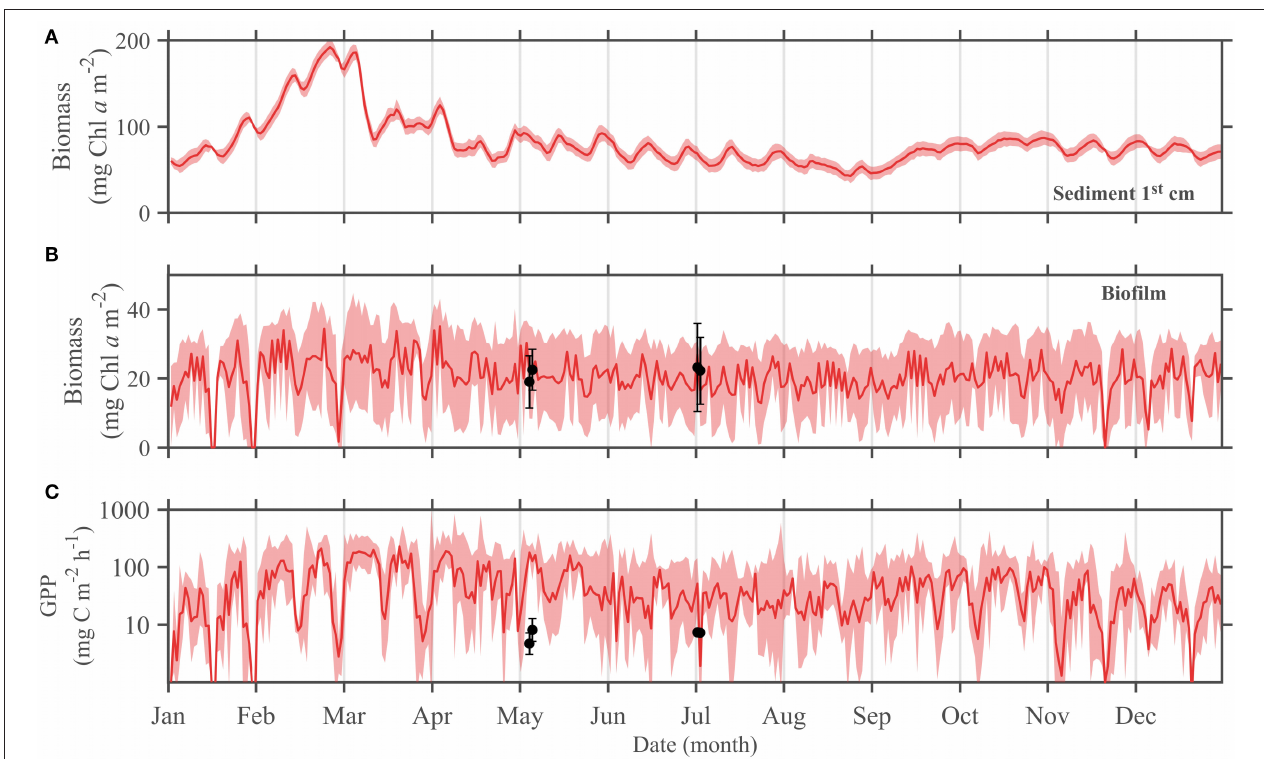
FIGURE 4 | Simulated mean seasonal cycle (MARS-3D season run) of the 2015 (A) daily mean MPB biomass in the sediment 1st cm, (B) daily mean MPB biomass in the biofilm (mg Chl a m − 2 ) and (C) hourly GPP (mg C m − 2 h − 1 ; log scale) averaged during daytime low tides at the sampling site. The bold line is the temporal mean over the respective periods and shaded areas correspond to the temporal standard deviation. Black dots and error bars correspond to the mean and standard deviation of the Chl a (mg Chl a m − 2 ) and GPP measured in situ .